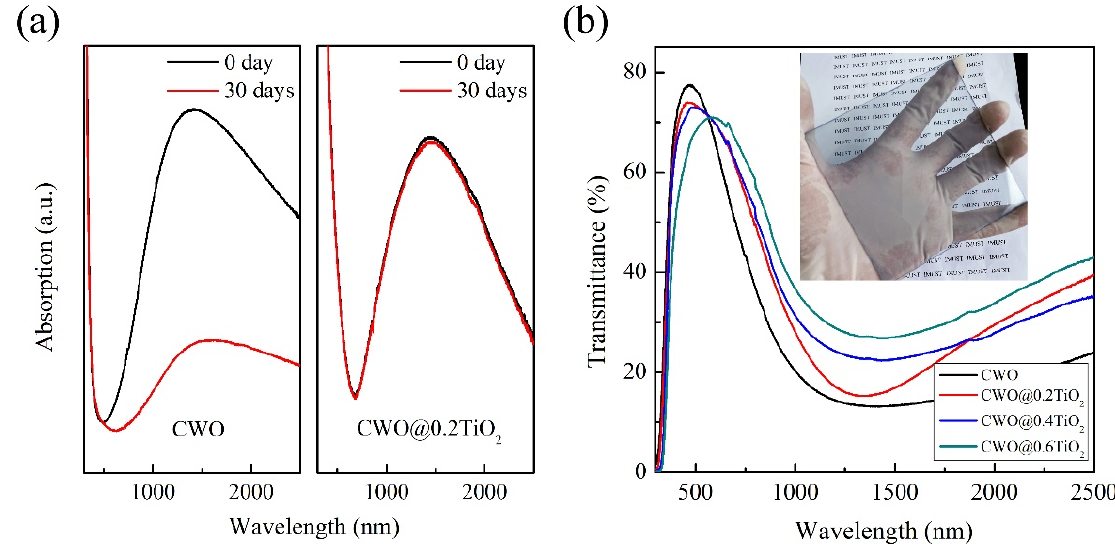
Figure 6. ( a ) The absorption curve of CWO and CWO@0.2TiO 2 nanoparticles after different durations, ( b ) Transmittance curve of coated glass (inset shows the CWO@0.2TiO 2 -coated glass used in the transmittance test).